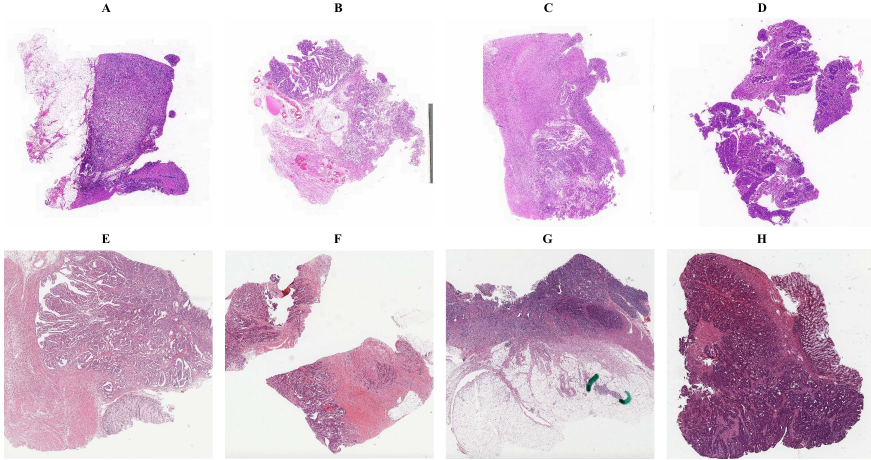
Figure 1. Representative H&E stained whole-side images (WSIs) from SYSU8H and TCGA-COAD dataset. The ( A – D ) and ( E – H ) samples are randomly selected from SYSU8H and TCGA-COAD datasets, respectively.